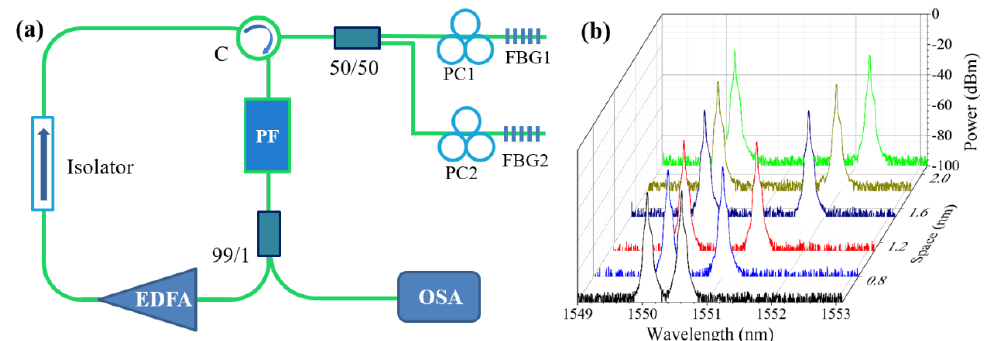
Figure 6. ( a ) Diagram of the dual-wavelength laser. Abbreviations: PC1 and PC2, polarization controllers; C, optical circulator; FBG1 and FBG2: fiber Bragg gratings; PF, polarization filter shown as the inset, which has been introduced in Figure 3; EDFA, erbium-doped fiber amplifier; isolator, optical isolator; 50/50 and 99/1, optical couplers and their ratios; and OSA, optical spectrum analyzer. ( b ) The tunability of the dual-wavelength laser.